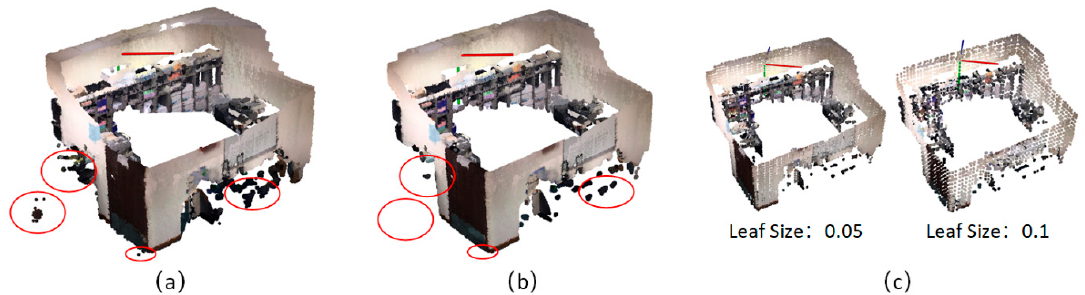
Figure 3. A sample of data pre-processing, ( a ) raw point cloud, ( b ) point cloud after outlier removal operation, ( c ) point cloud after down-sampling with different voxel size.